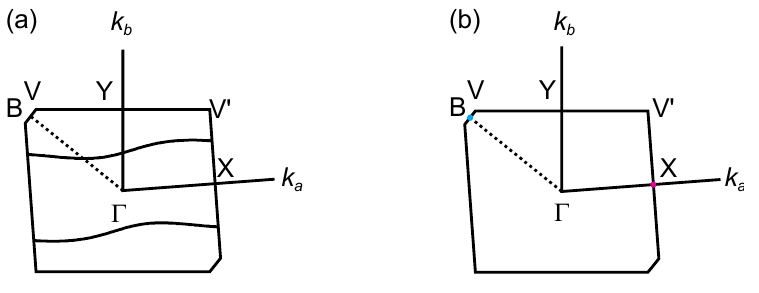
  BV V'Y Figure 12. ( a ) Calculated Fermi surfaces of the composition of − )(H (MeDTES) 0.5+ (ReO O + ) . ( b ) Calculated Fermi points of the composition of 4 3 0.5 − )(H (MeDTES) + (ReO O) . 4 2 0.5